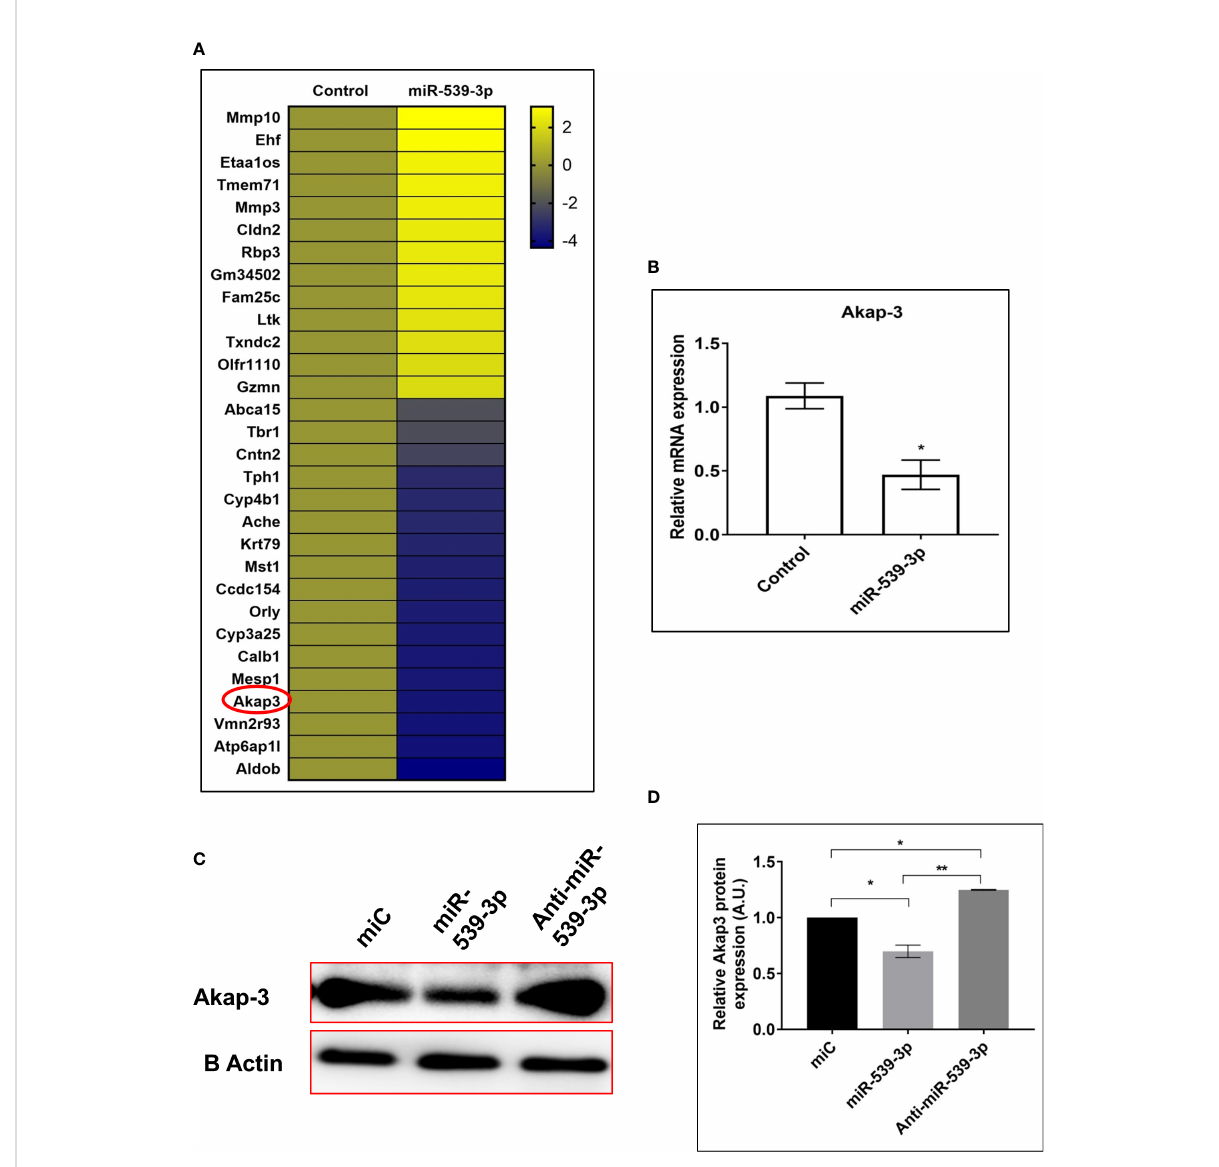
FIGURE 8 (A) Heat map of differentially regulated genes in control and miR-539-3p treated conditions (n=2). (B) RT-PCR validation of Akap-3 gene in control vs miR-539-3p transfected osteoblast cells. Data are expressed in means ± S.E. (n = 6). *P < 0.05 compared with control. (C) Western blot analysis of Akap-3 in miC, miR-539-3p and anti-miR-539-3p transfected cells after 48 h of transfection. (D) Densitometry of blots (n=3). Data are expressed as mean ± SEM (n=6) *P < 0.05 and **P < 0.01 compared in between